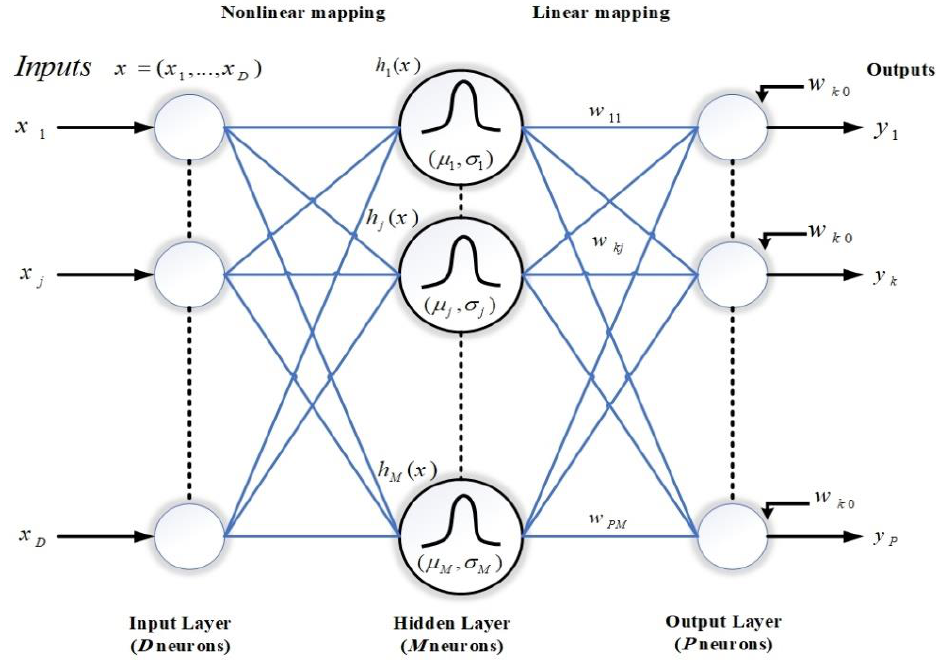
Figure 19. The architecture of an RBF network.